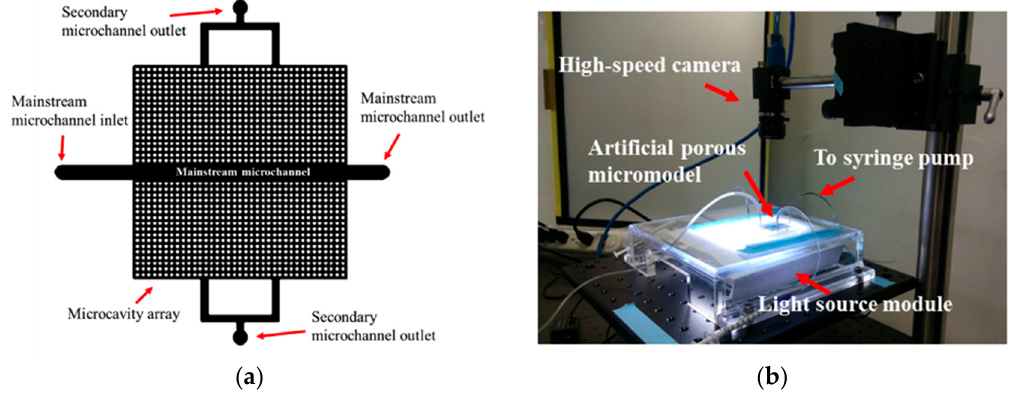
Figure 1. ( a ) Artificial porous micromodel design to mimic a natural fractured porous material. ( b ) Photograph of the porous micromodel experimental setup.